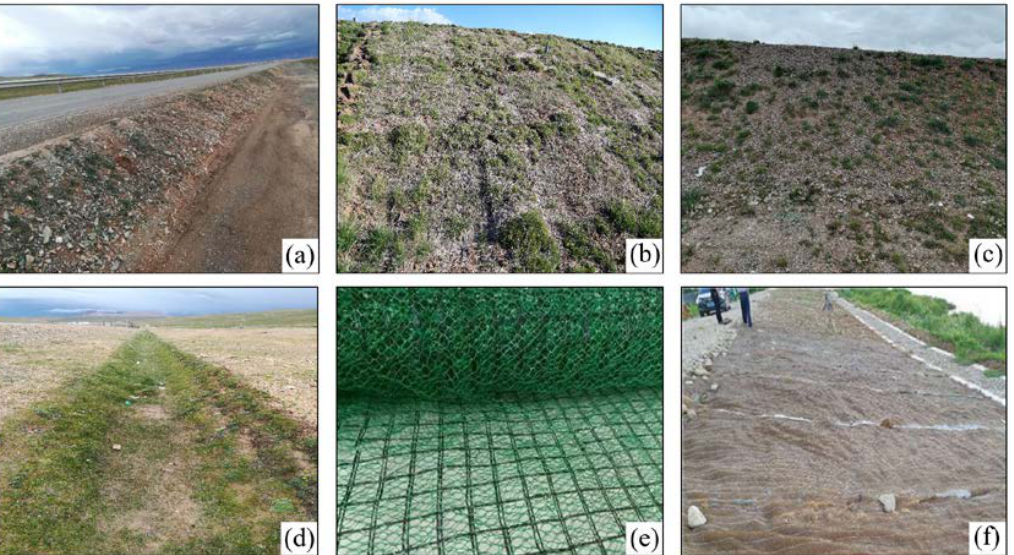
Figure 2. Ecological protection measures. ( a ) Gravel cover protection. ( b ) Full turfing protection. ( c ) Strip turfing protection. ( d ) Block turfing protection. ( e )Three-dimensional net seeding protection. ( f ) Coconut fiber blankets protection.